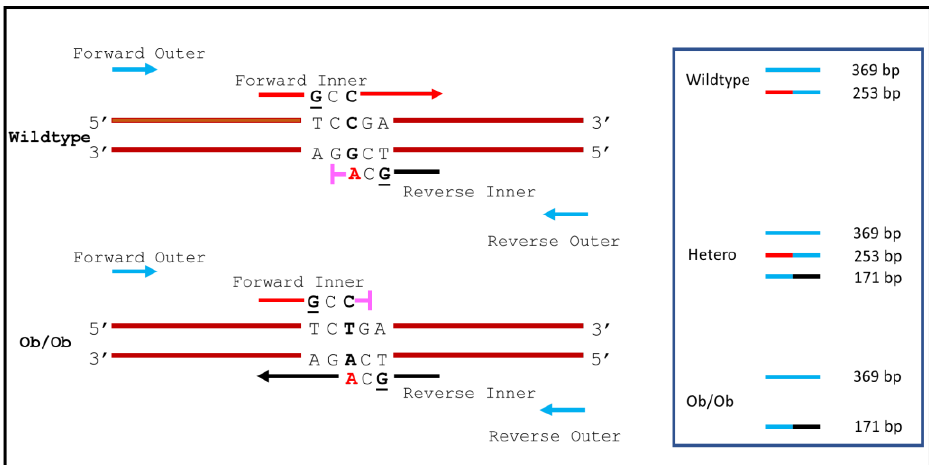
Figure 1. Diagram of the DNA amplicon patterns representing different genotypes on the agarose gel. Different colors indicate different primers participating in the PCR reaction. The two outer primers (blue-colored) are annealed at locations with different distances from the SNP site to ensure the production of two allele-specific PCR amplicons of different sizes distinguishable on the agarose gel. The base “G” (underlined) in the Forward Inner primer (red) and the Reverse Inner primer (black) were purposely introduced at position − 2 from the 3′ terminal of each allele -specific primer to increase the specificity of the PCR reaction. reaction cannot proceed.